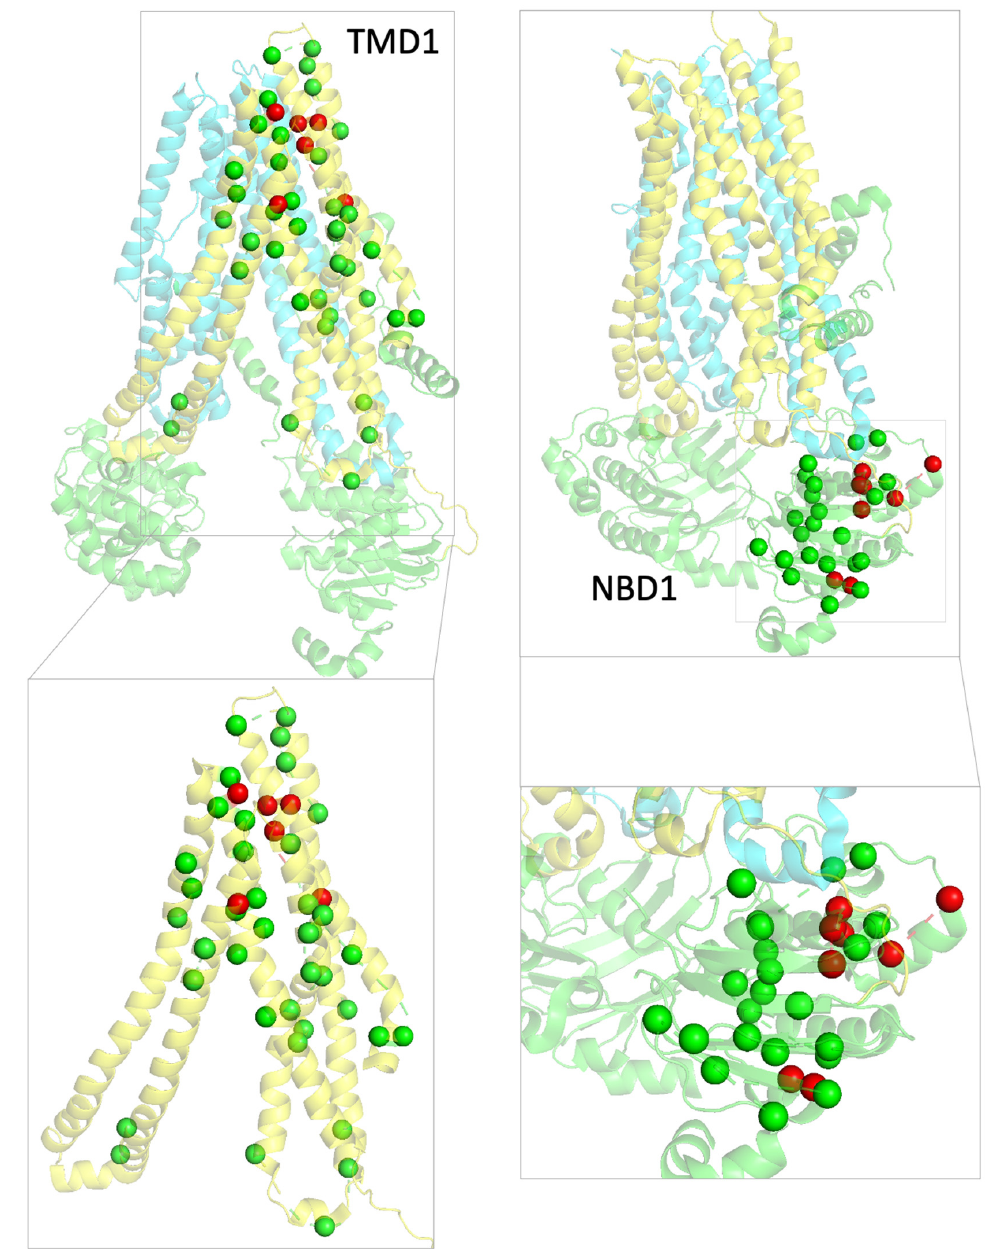
Figure 5. General view of CFTR structure (PDB: 5UAK) with TMD1 in yellow, TMD2 in blue, NDB1 and NBD2 in green. Mutations listed in CFTR2 located in TMD1 or NBD1 are identified as green or red spheres according to their eligibility for Trikafta (green—eligible, red—non eligible). Insets allow a closer view of the distribution of mutations in the two domains.